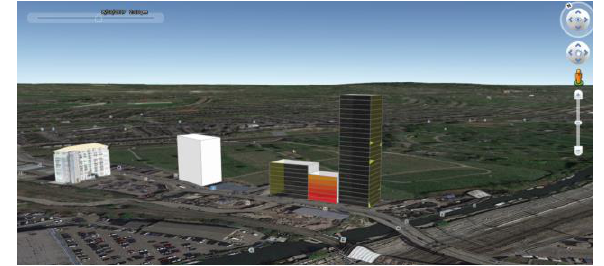
Figure 6 The noise model at 2 pm as seen from the south-east side of the development.